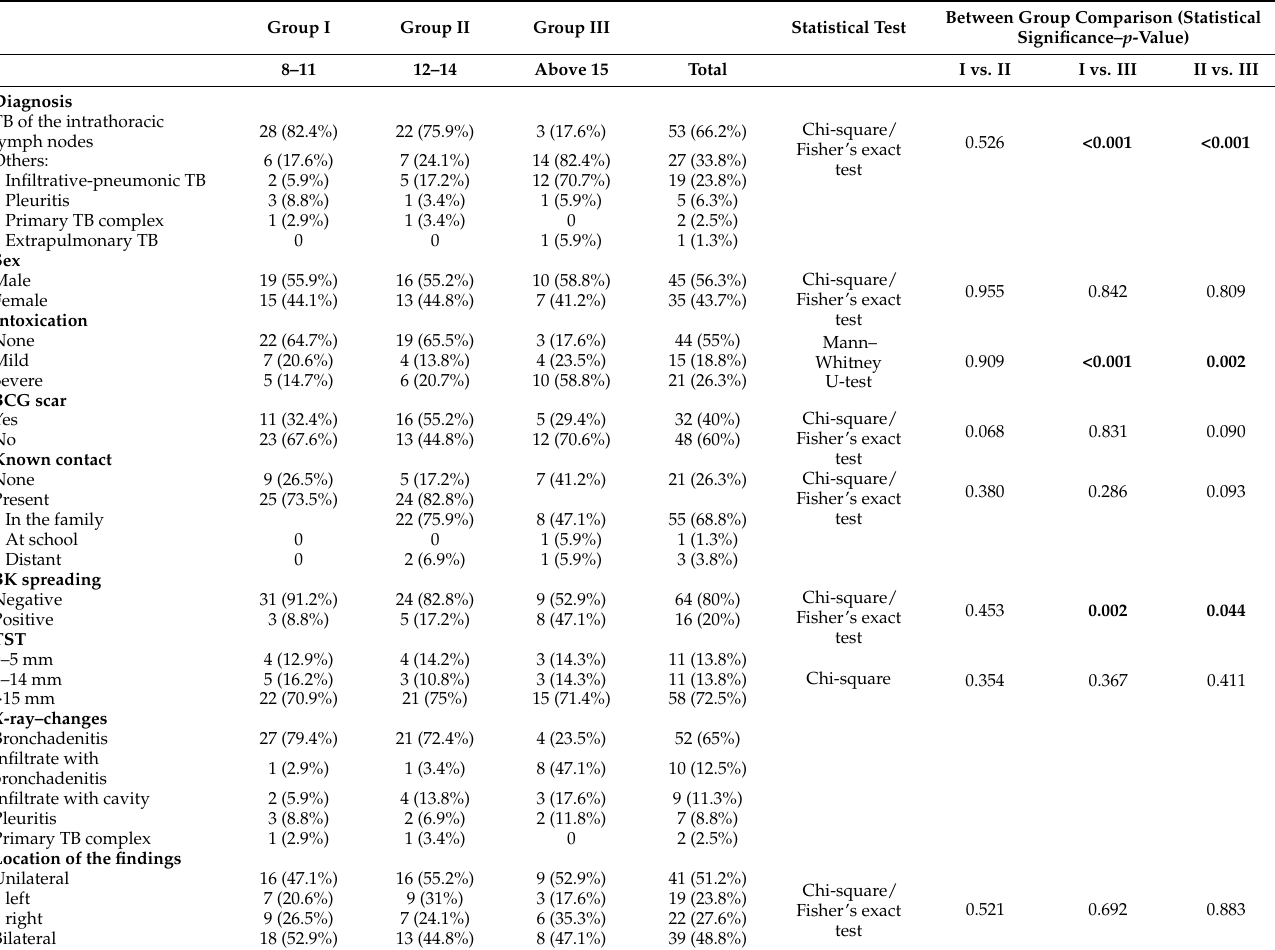
Table 1. Descriptive statistics and comparison between the three age